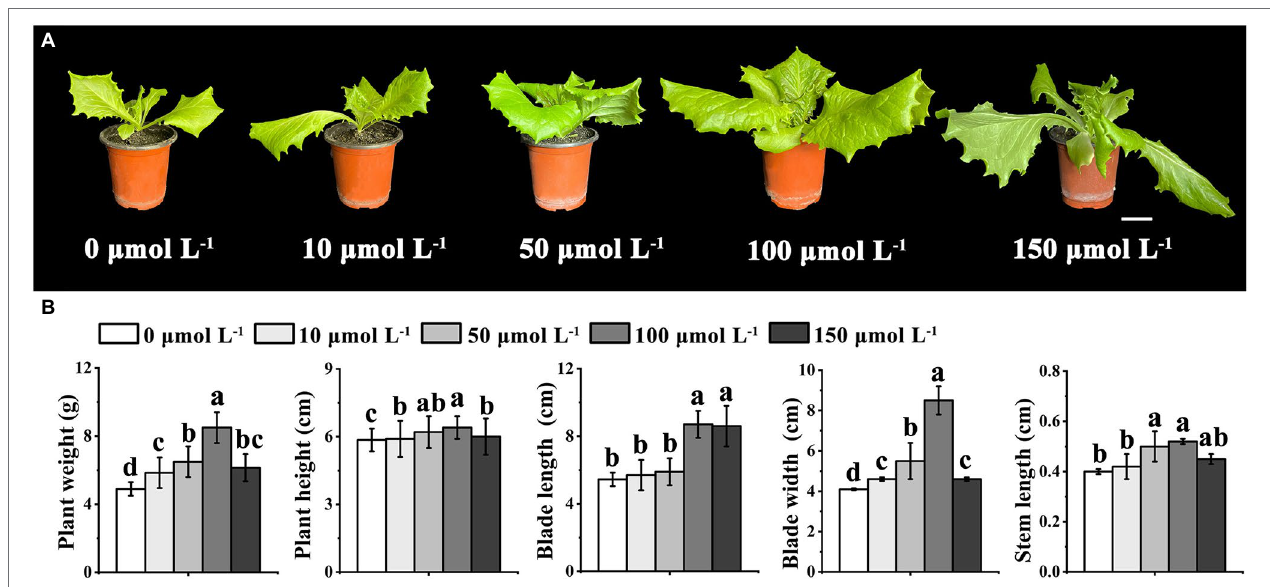
FIGURE 1 | Effects of different concentrations of melatonin treatment under control temperature (20 ° C) on growth and development in leaf lettuce. (A) Leaf lettuce of the bolting-sensitive line S39 treated with 0, 10, 50, 100, and 150 μ mol L − 1 melatonin, corresponding to the morphological features of five different concentrations. Scale bars = 5 cm. (B) The weight, height, blade length, blade width, and steam length of leaf lettuce in five different concentrations of melatonin. Different letters above the bars indicate significantly different values ( p < 0.05) calculated using one-way analysis of variance (ANOVA) followed by a Tukey’s multiple range